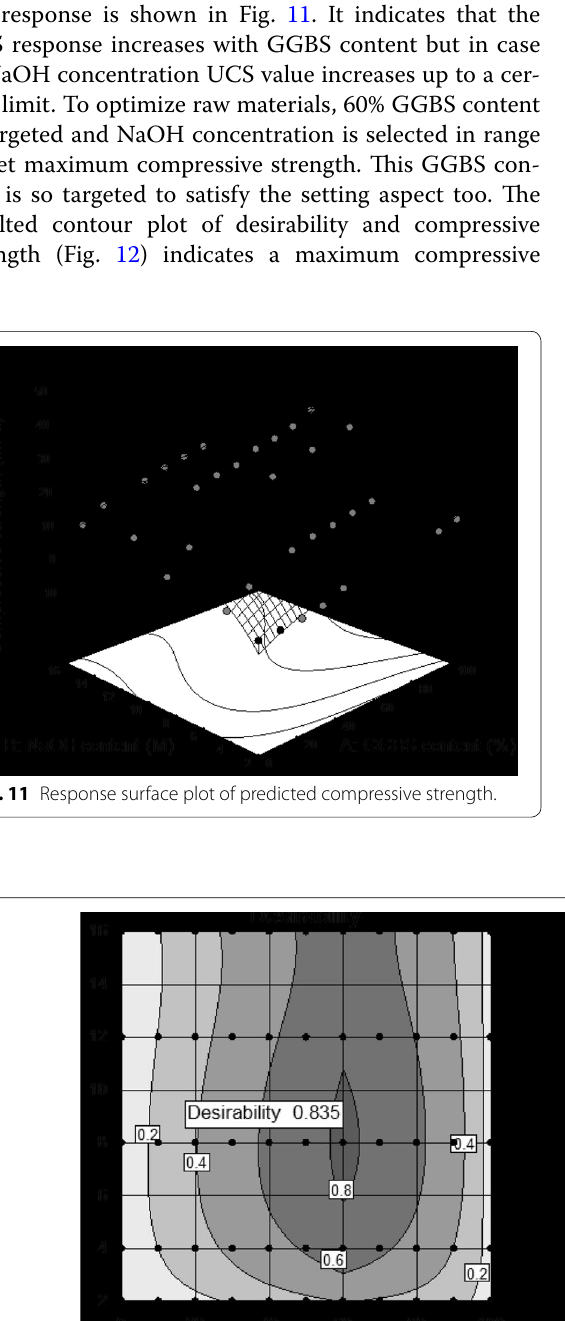
Fig. 12 Contour plot of desirability and compressive